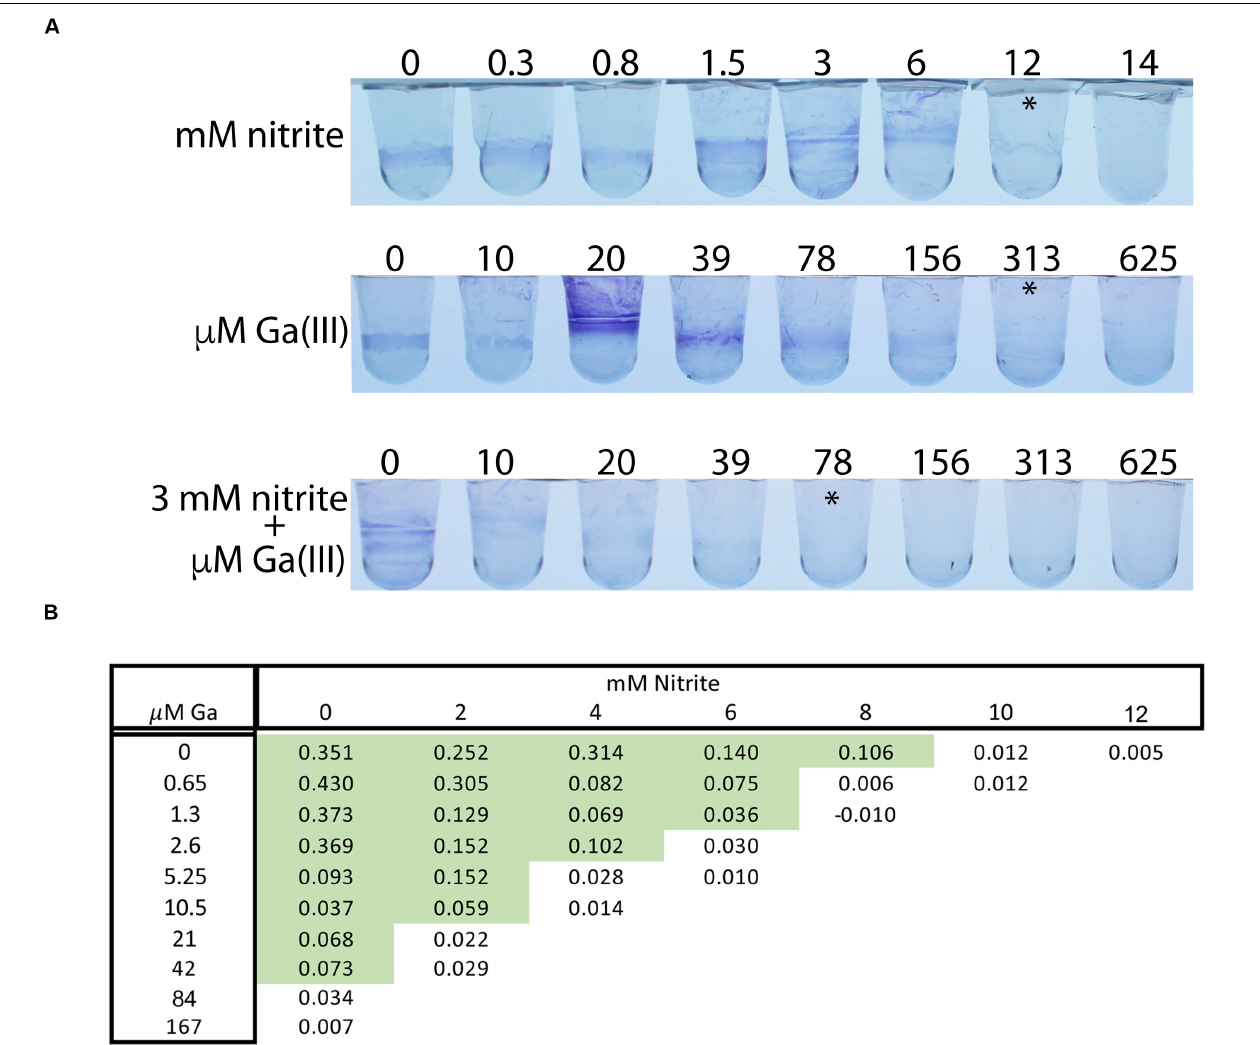
FIGURE 4 | (A) PAO1 biofilms grown on CF airway epithelial cells were treated for 90 min with Ga or NIT for 90 min and live CFUs were plated. Ga 3 + shows dose dependent bacterial killing that is increased with the addition of nitrite. Dashed line is assay detection limit. (B) Tran-epithelial electrical resistance of airway cells treated with the indicated combinations for 60 min. p < 0.001 by one-way ANOVA followed by post hoc test. Replicates done: 3–4/condition tested. ∗ Indicates visual MIC